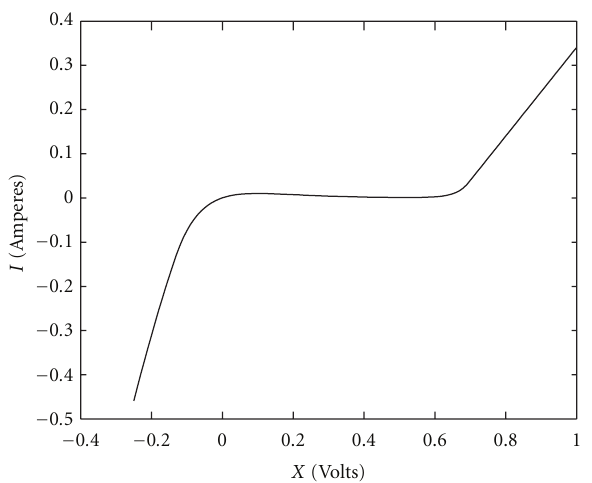
Figure 8: Esaki tunnel diode current with respect to state variable.